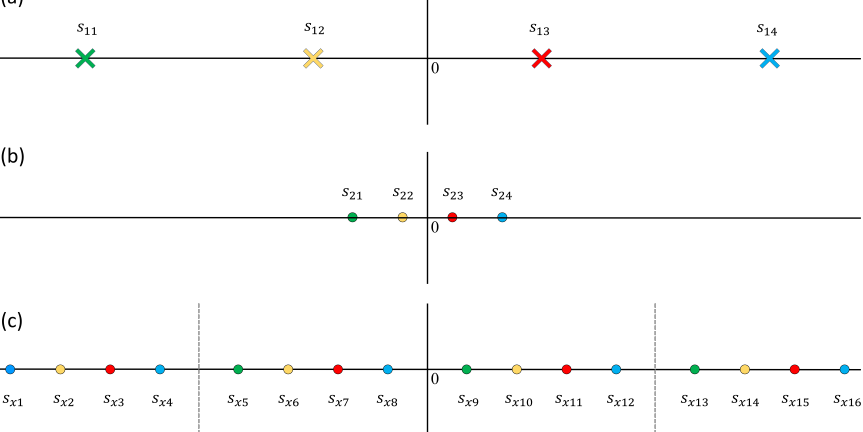
Figure 6. Signal constellation when both users have 4-PAM. ( a ) user 1, ( b ) user 2, and ( c ) superposed signal ( x